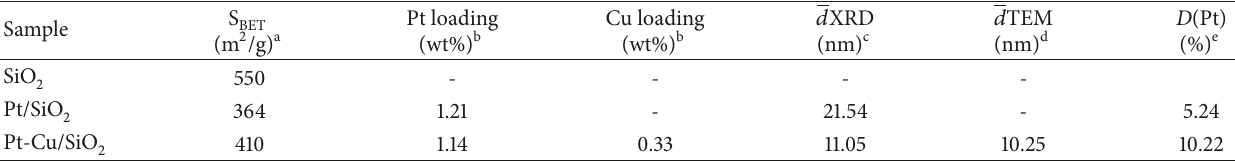
Table 1: Physicochemical properties of Pt-Cu/SiO 2 catalysts.